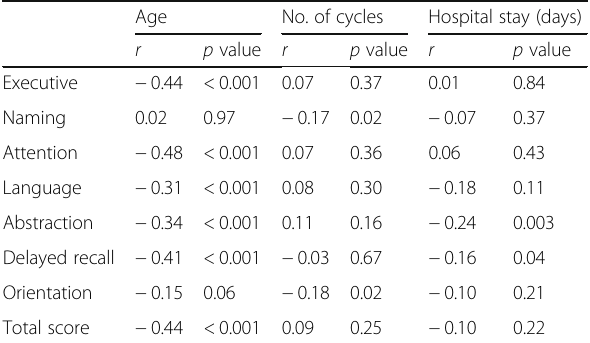
Table 3 The correlation of the age of patients, number of chemotherapy cycles received, and period of hospital admission with each component of Montreal scoring